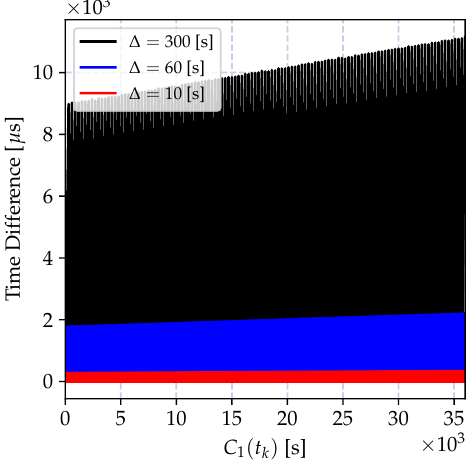
Figure 7. The time difference in microseconds between the time reports of a local clock and a reference clock when the time-offset is estimated at different periods ∆